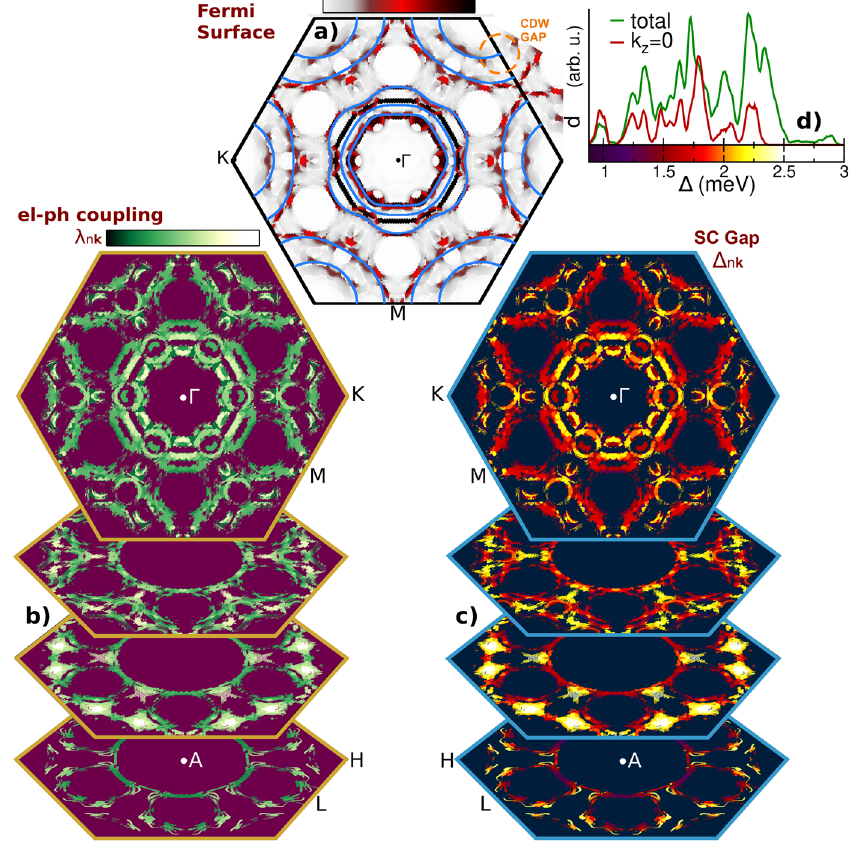
Fig. 3 Fermi surface anisotropy of the electron-phonon coupling and superconducting gap. a k z = 0 cut of the NbSe 2 Fermi surface obtained by unfolding the BZ. Color scale indicates the relative spectral weight. Blue curves represent the unperturbed FS sheets. b Electron – phonon coupling and ( c ) low-temperature superconducting gap computed in the unfolded BZ at random points on constant- k z slices (of 0 : 1 π width) and within ±0.1 mRy from the Fermi level. d Distribution of gap values computed over the full BZ (green) and the c j k j < 0 : 1 π slice (red). z c